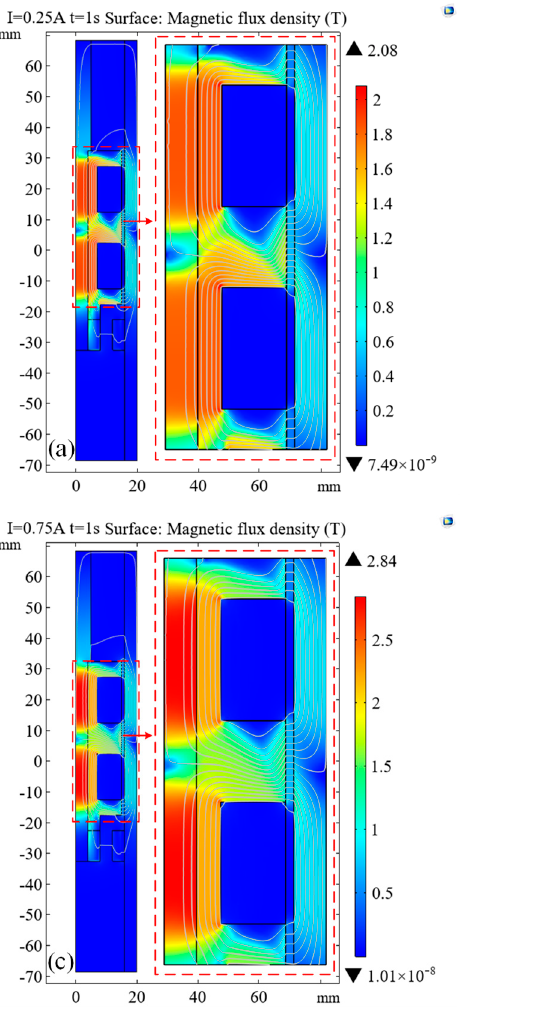
Figure 4. Magnetic field distribution for: ( a ) I = 0.25 A; ( b ) I = 0.5 A; ( c ) I = 0.75 A; and ( d ) I = 1 A.